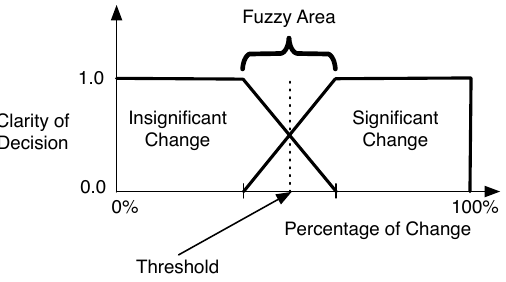
Figure 4. Fuzzified mechanism to determine the significance of change of a node’s